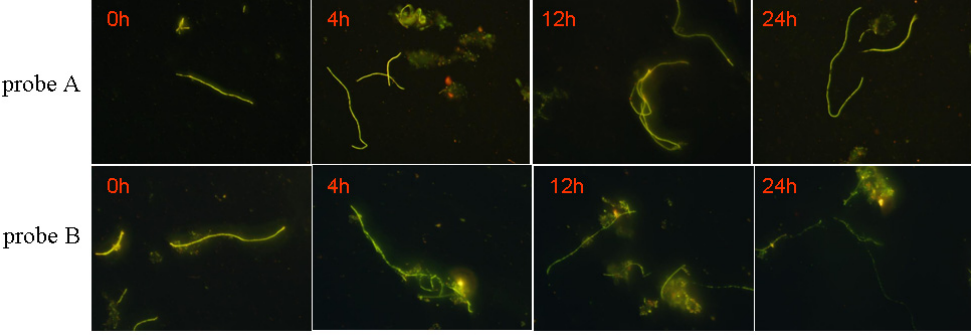
Figure 6. Images of the probes A and B duration time in labeling.